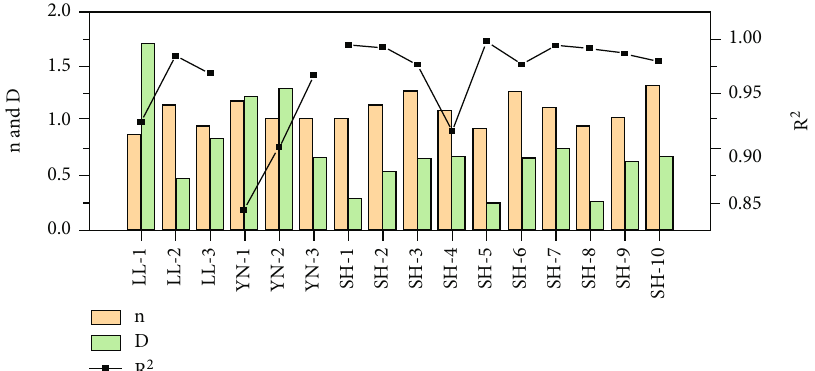
Figure 7: The Rosin-Rammler distribution model.